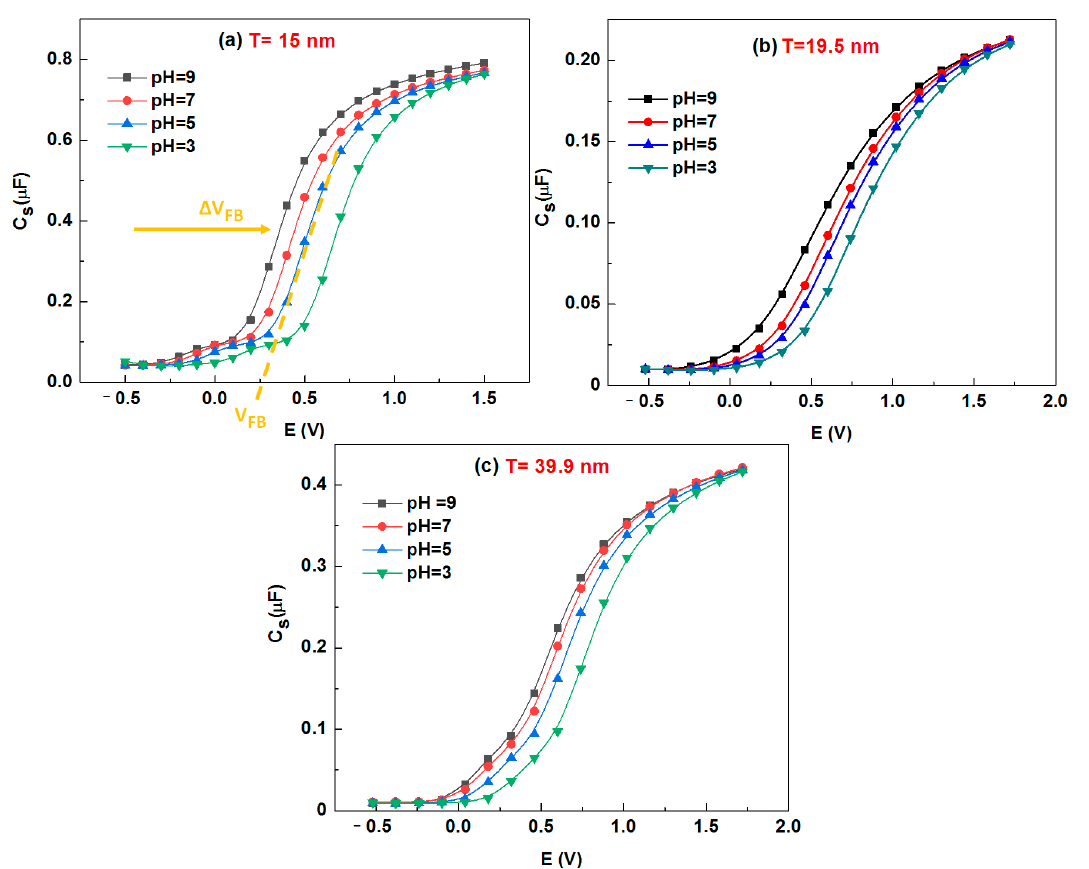
Figure 4. Typical C(V) curves for different hafnium thicknesses ( a ) 15.0 nm, ( b ) 19.5 nm and ( c ) 39.9 nm stacked HfO 2 structures for various pH buffer solutions using 0.4 M Mg (NO 3 ) 2 prepared in TRIS buffer. The pH was adjusted by the HCl solution (C = 1 M).